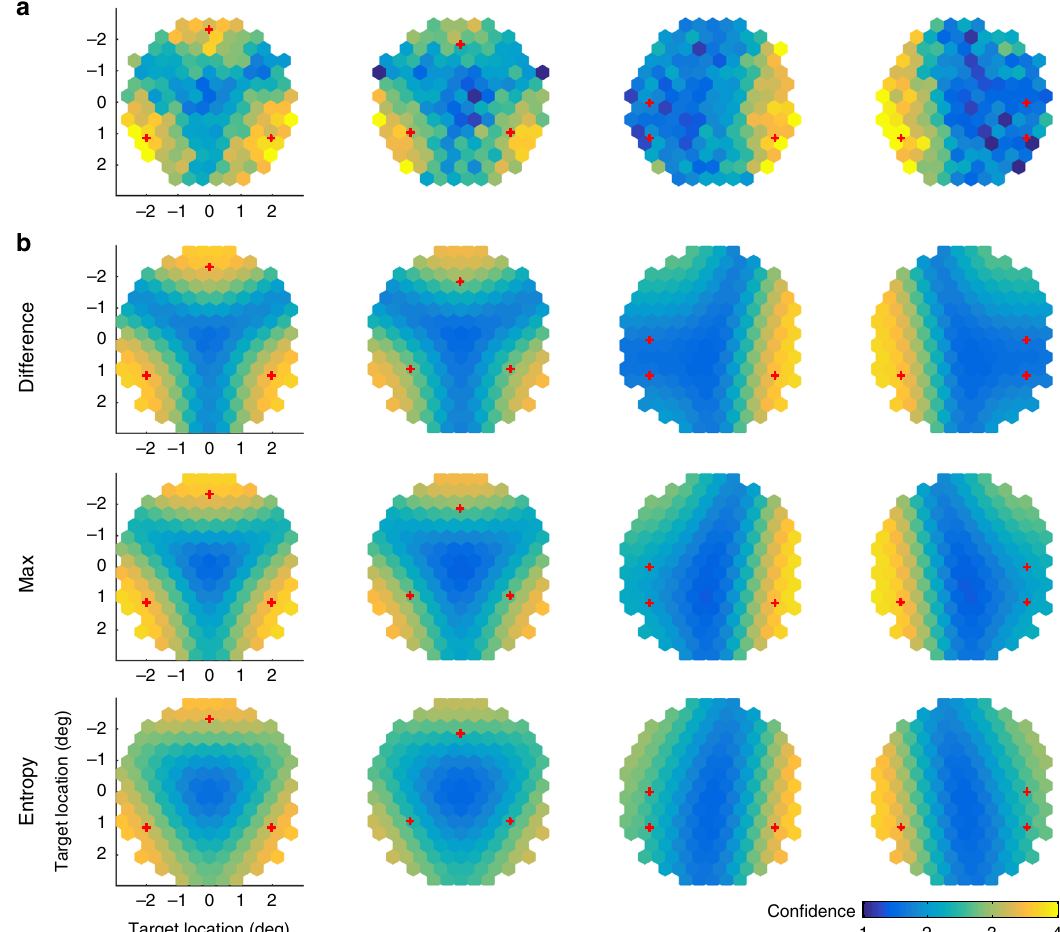
Fig. 5 Experiment 2. a The mean con fi dence report as a function of target positions. b Model fi t averaged across individuals. The red crosses in each panel represent the center of each of the three